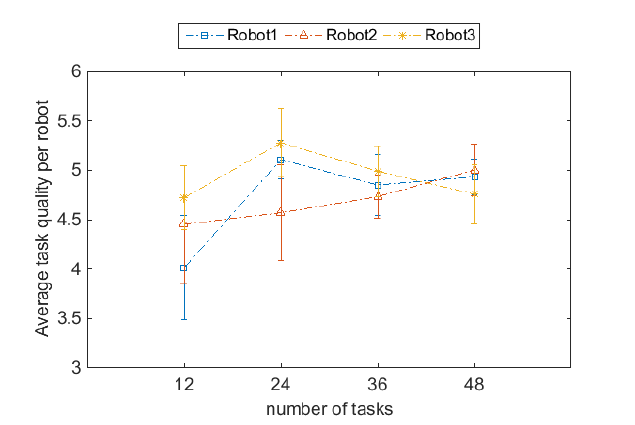
Figure 14. Comparison between DYMO-Auction and Fuzzy Logic Multiple Traveling Salesman Problem (FL-MTSP) in terms of total traveled distance.